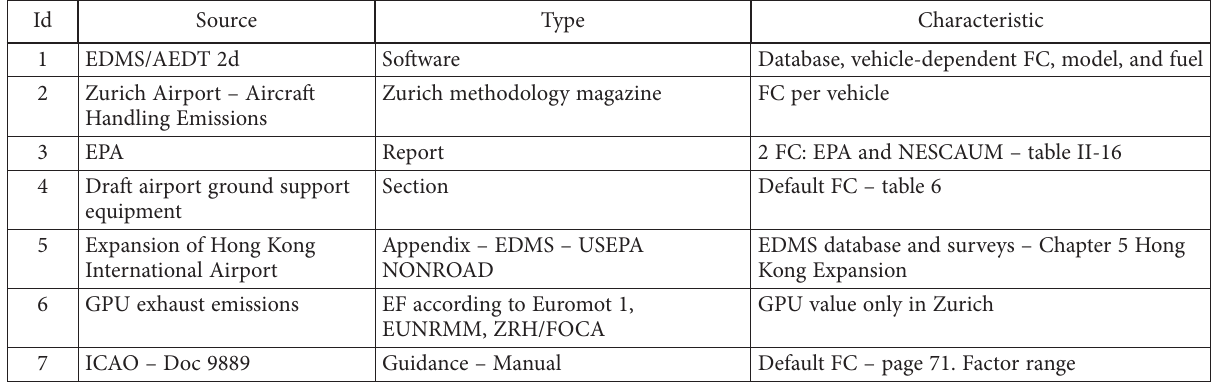
Table 1. Loading factors for GSEs according to the bibliography (source: